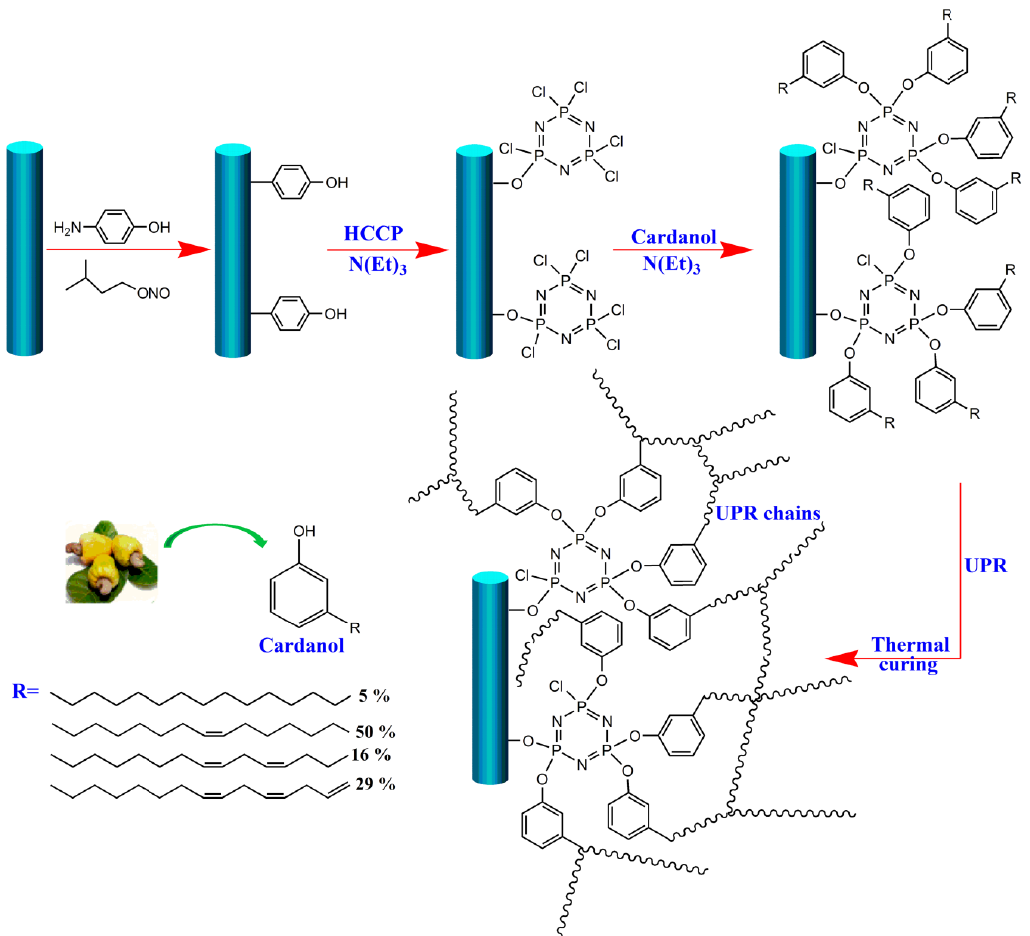
Figure 1. Schematic illustration of the preparation procedure of CF-cardanol and the interfacial reaction between modified CFs and the matrix. HCCP: hexachlorocyclotriphosphazene, UPR: unsaturated polyester resin.